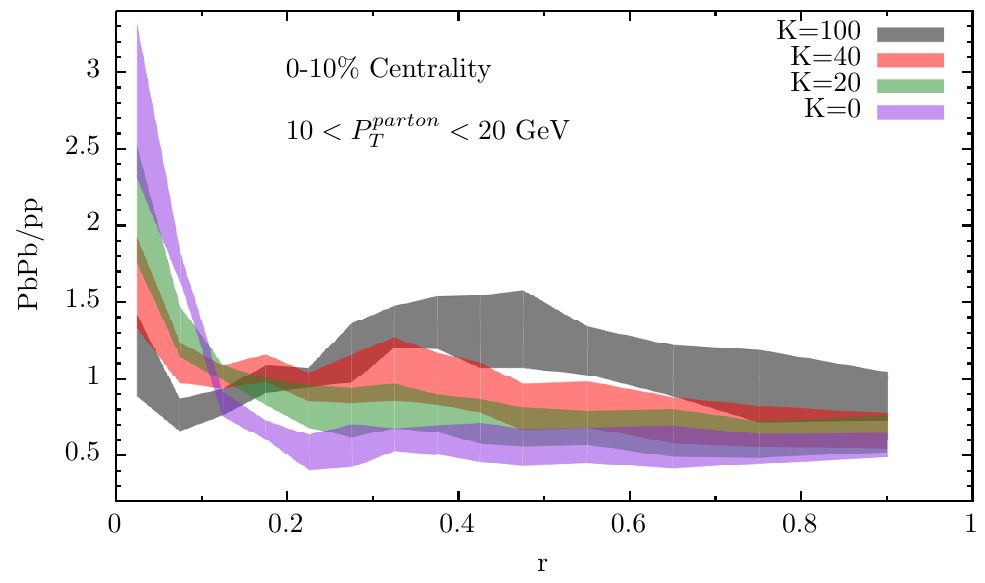
Figure 6 . Di(cid:11)erential jet shape ratio constructed from the subleading jets in dijet pairs satisfying p Tleading > 120 GeV, p Tsubleading > 30 GeV, and (cid:1) (cid:30) > 5 (cid:25)= 6. The analysis only includes partons whose p T lies within the intermediate range 10 < p T < 20 GeV. The e(cid:11)ect of broadening on this observable is